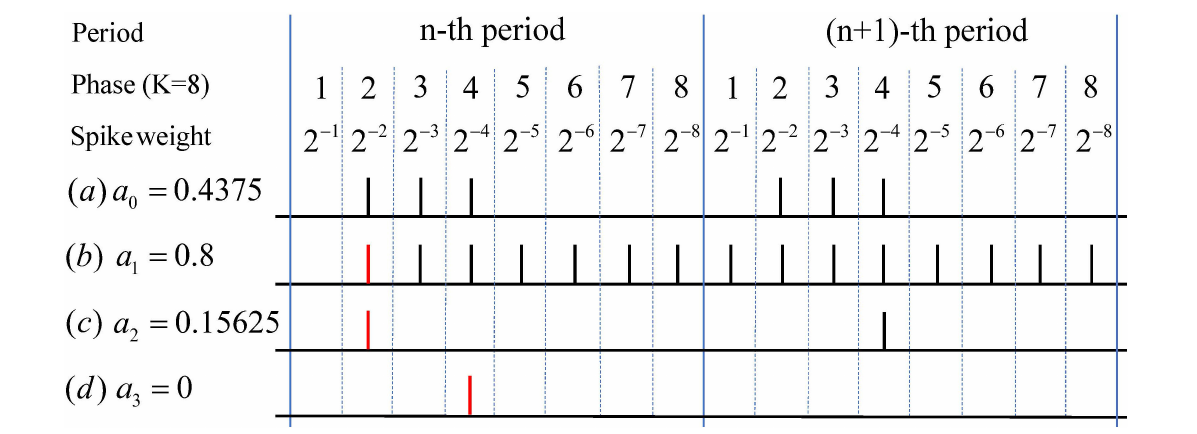
FIGURE2 Examples of Phase Lag, Phase Lead, and SIN. Real value a 0 in (a) can be accurately represented with few spikes in phase coding. While due to the uncertainty of the postsynaptic current, phase lag problem like (b) occurs when the membrane potential in the current phase exceeds the threshold at the previous moment. When a current greater than one is suddenly received at a certain moment, phase lead problem like (c) will occur. Both of these problems will directly or indirectly lead to SIN in (d), where neurons corresponding to the activation value of zero will also